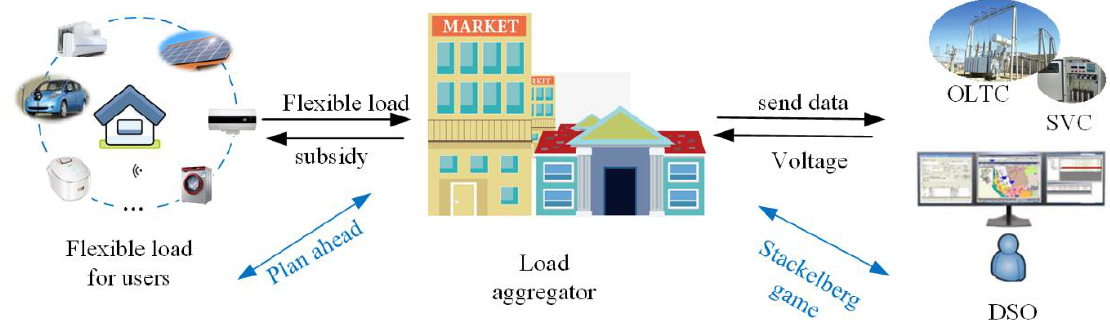
Figure 1. Game diagram between the distribution system operator and a load aggregator.